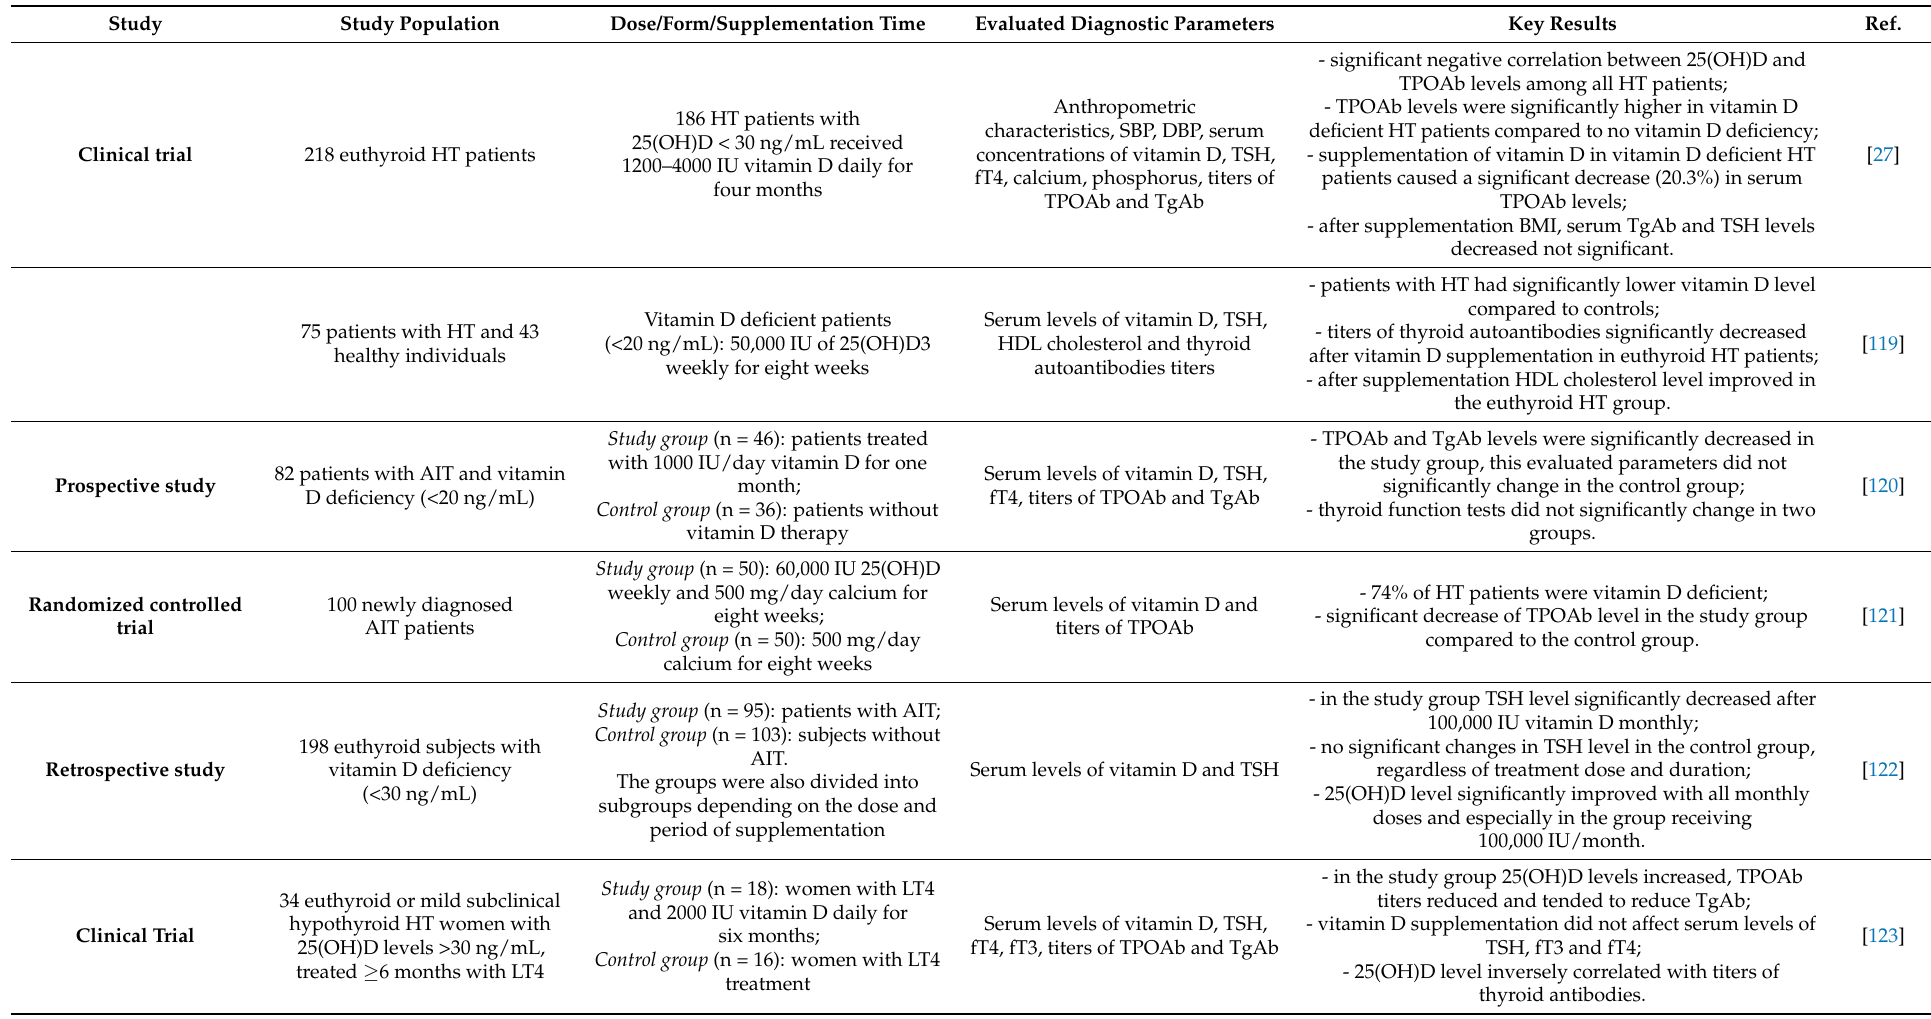
Table 2. Effect of vitamin D supplementation on selected parameters in patients with Hashimoto’s thyroiditis—recent clinical